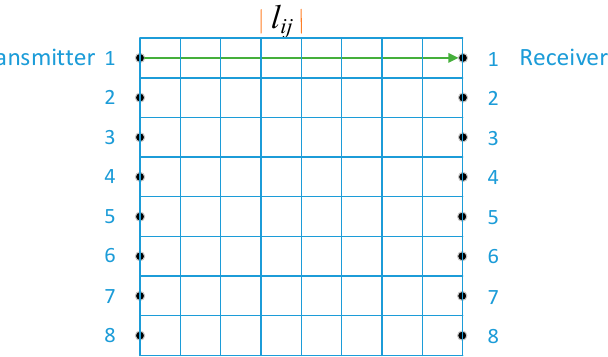
Figure 1. Two linear arrays are mounted on a plate.